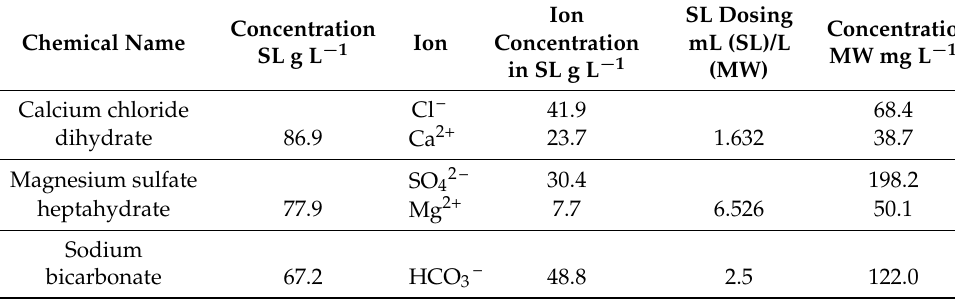
Table 6. C. Test water for hardness high—Experiment